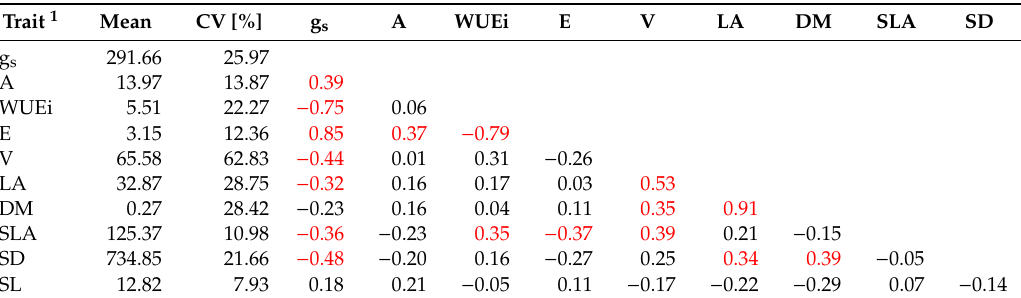
Table 2. Mean values, coe ffi cients of variations (CV) and correlation coe ffi cients between volume, physiological and morphological traits. Red colour denotes a statistically significant correlation at a level of α = 0.05.